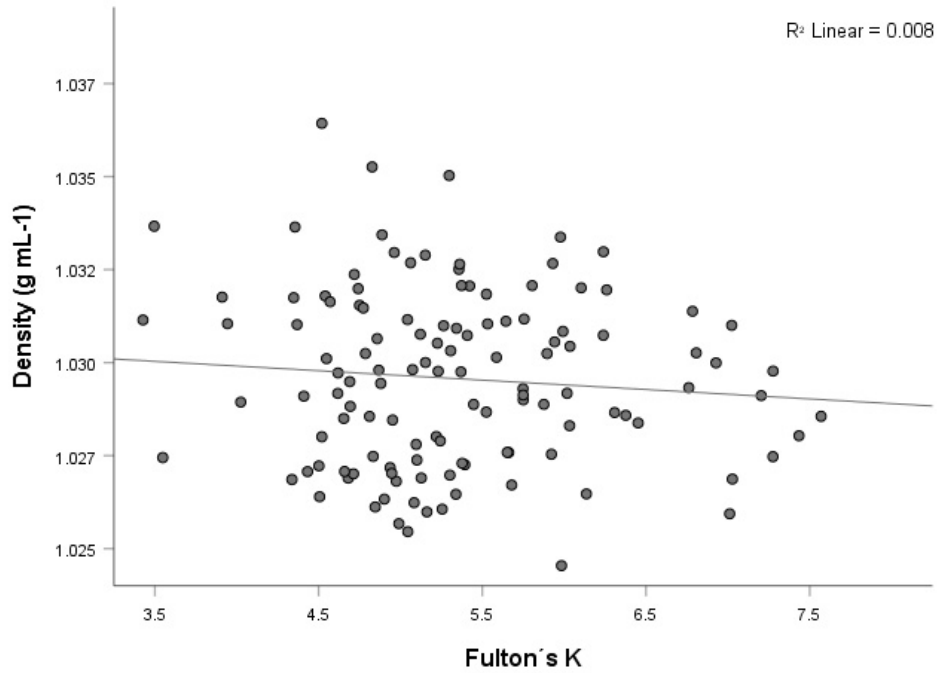
Figure 3. A scatterplot with a fit line of body density by Fulton’s K ( n = 123). Location D was excluded from the analysis (see text for explanation).